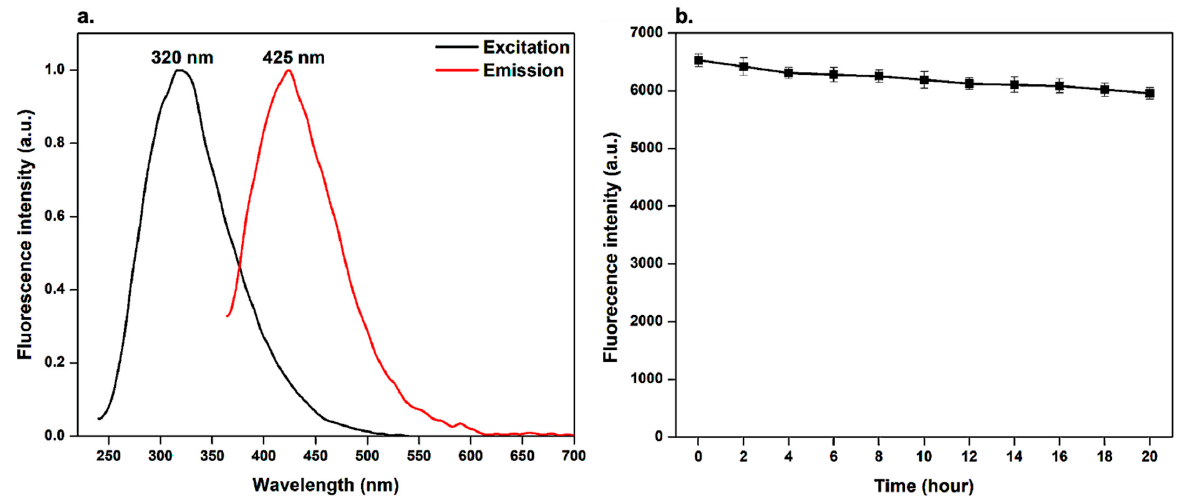
Figure 6. Fluorescence measurements for BCDs nano-biocarrier. ( a ) Fluorescence maximum excitation ( λ excitation = 380 nm) and emission ( λ emission = 480 nm) spectra, and ( b ) fluorescence intensity upon continuous excitation with UV-lamp at wavelength 365 nm.